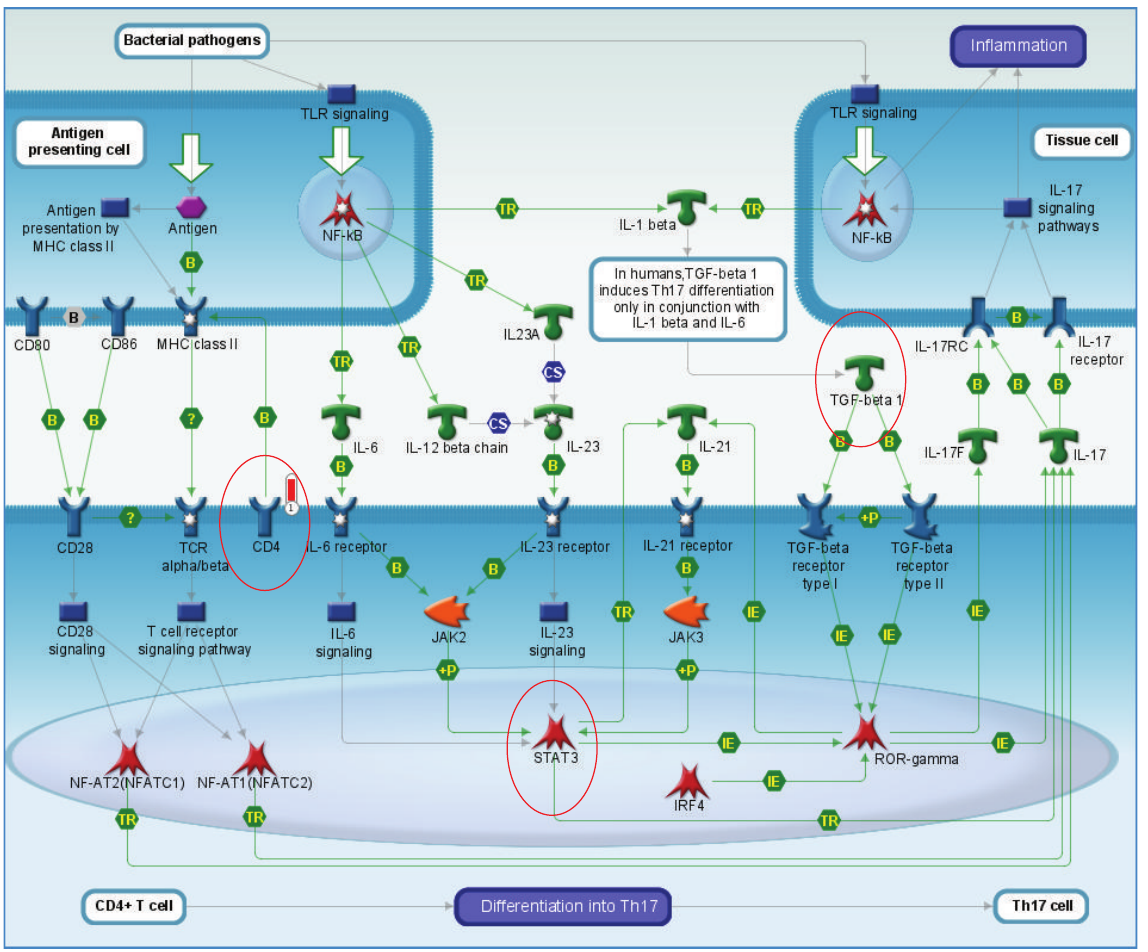
Figure 3: Immune response and Th17 cell differentiation. Differences in Th17 polarisation were observed when controls were compared with T1D patients using microarray data. Genes of interest were analysed by qRT-PCR and were found to be upregulated in T1D patients. STAT3 and TGF-beta were chosen as representatives of Th17 cell differentiation. Microarray data demonstrated that CD4 was one of the most significantly upregulated molecules in T1D